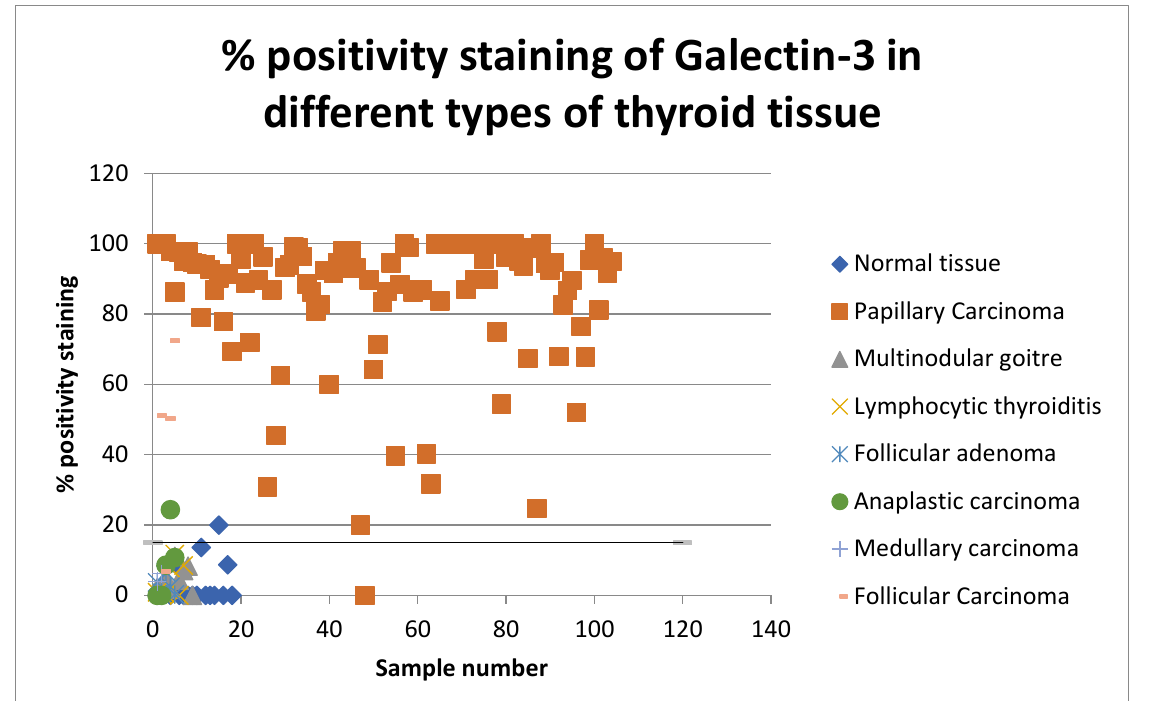
Figure 2. Scatter graph showing percentage positivity staining rates of HBME-1 in all types of thy- roid tissue in 2008 and 2013.